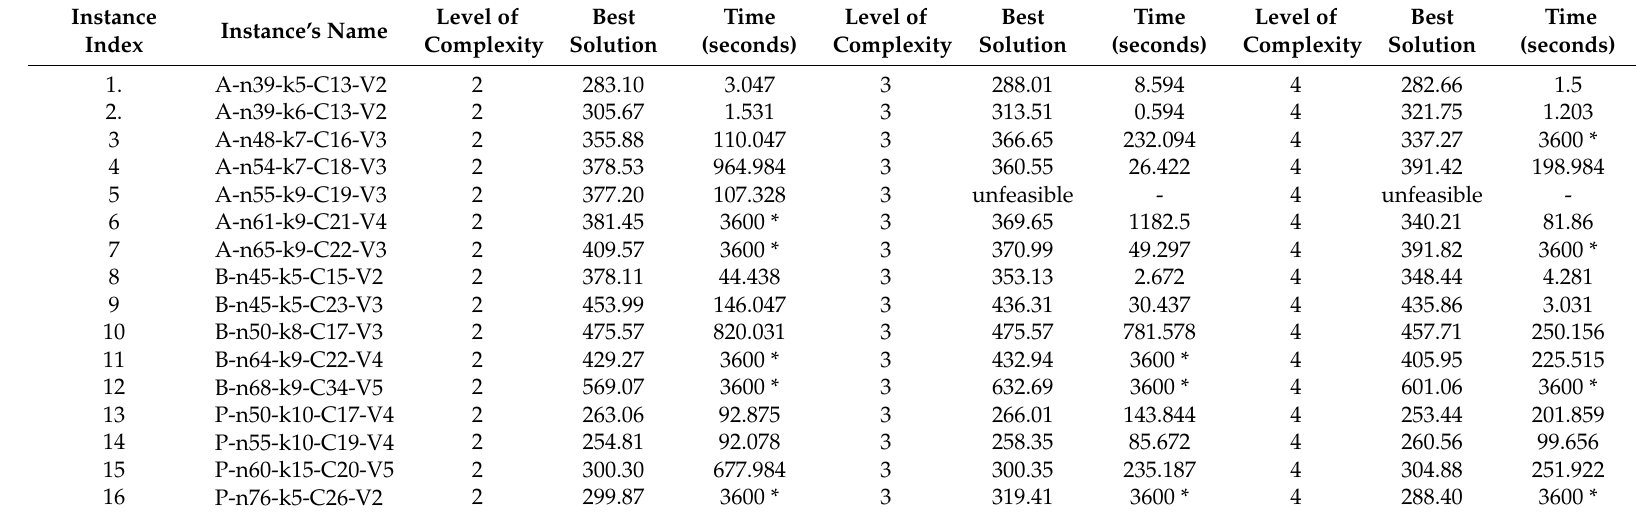
Table 4. Experimental results for solving larger SVRP with levels of complexity 2, 3 and